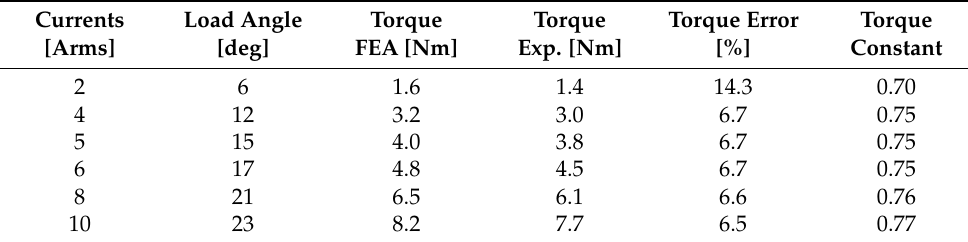
Table 10. Comparison of torque characteristics in relation to current for three-phase operation.